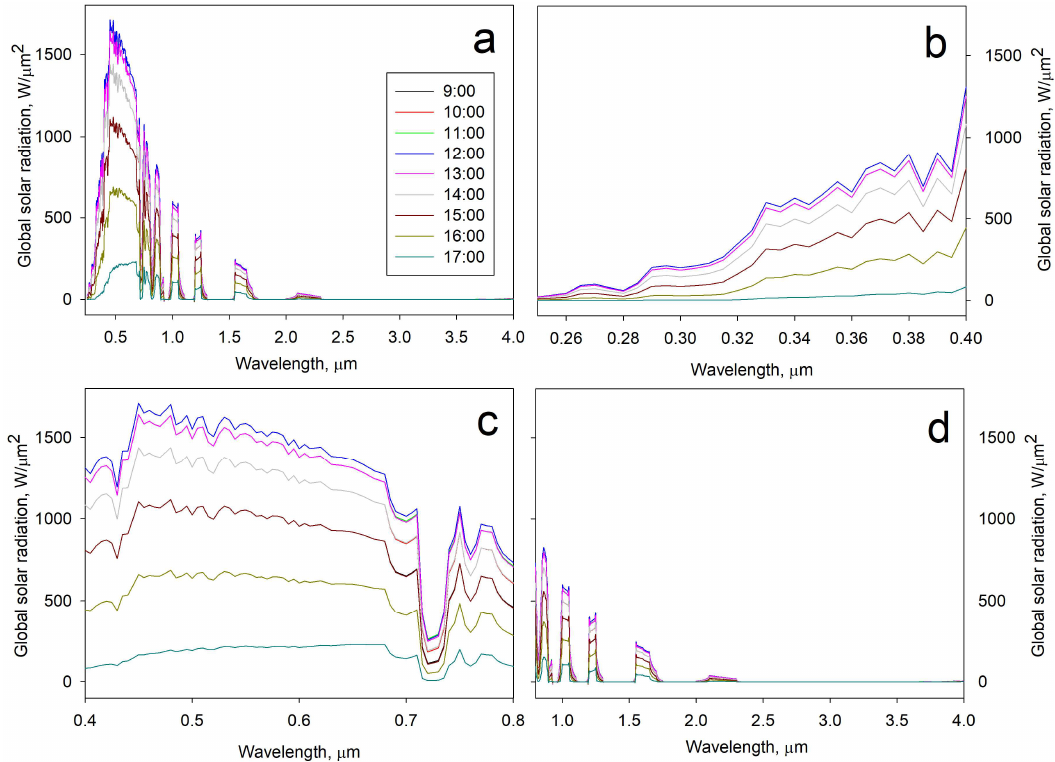
Figure 9. Example of the solar spectrum (first round of the experiments): ( a ) total solar irradiance; ( b ) the UV component of solar irradiance; ( c ) the visible component of solar irradiance; and ( d ) the IR component of solar irradiance.